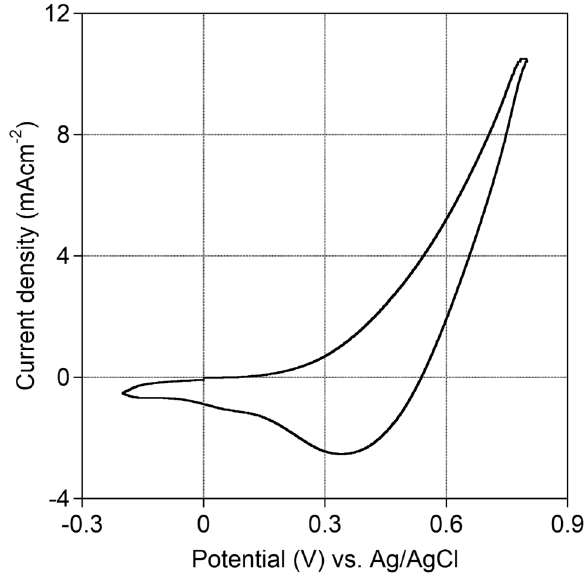
Fig. 3 CV curves for Nafion/CuO NPs at 0.1 M NaOH in the absence of glucose. The scan rate is 100 mV s −1 . The curve is an average of three trials in every three sensors